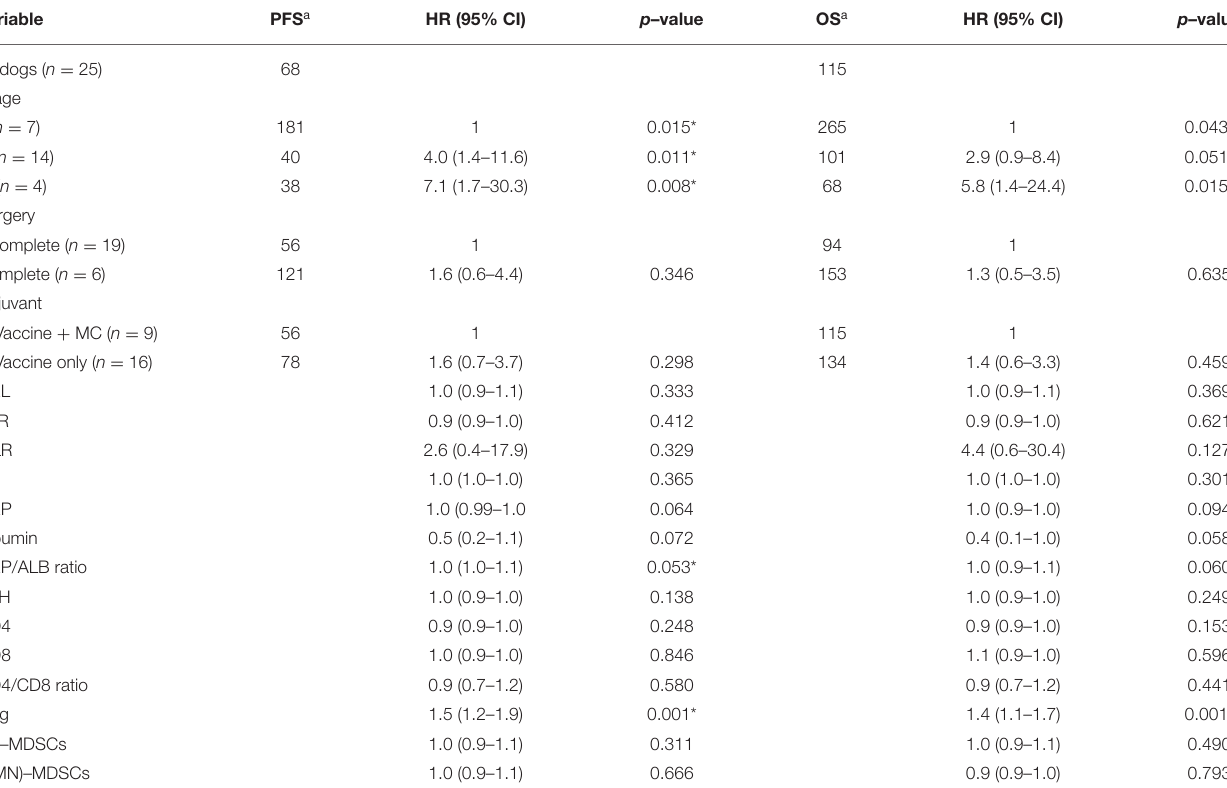
TABLE 3 | Effect of clinical stage, surgical margins, adjuvant treatment (tumor lysate vaccine alone or plus MC), inflammatory indices (NRL, PLR, MLR, SII, and CRP/ALB ratio), albumin, LDH, and frequency of circulating cells (lymphocytes CD4, CD8, CD4/CD8 ratio, Tregs, (M)-MDSCs, and (PMN)-MDSCs) on the PFS and OS of 25 canine patients with oral melanoma.